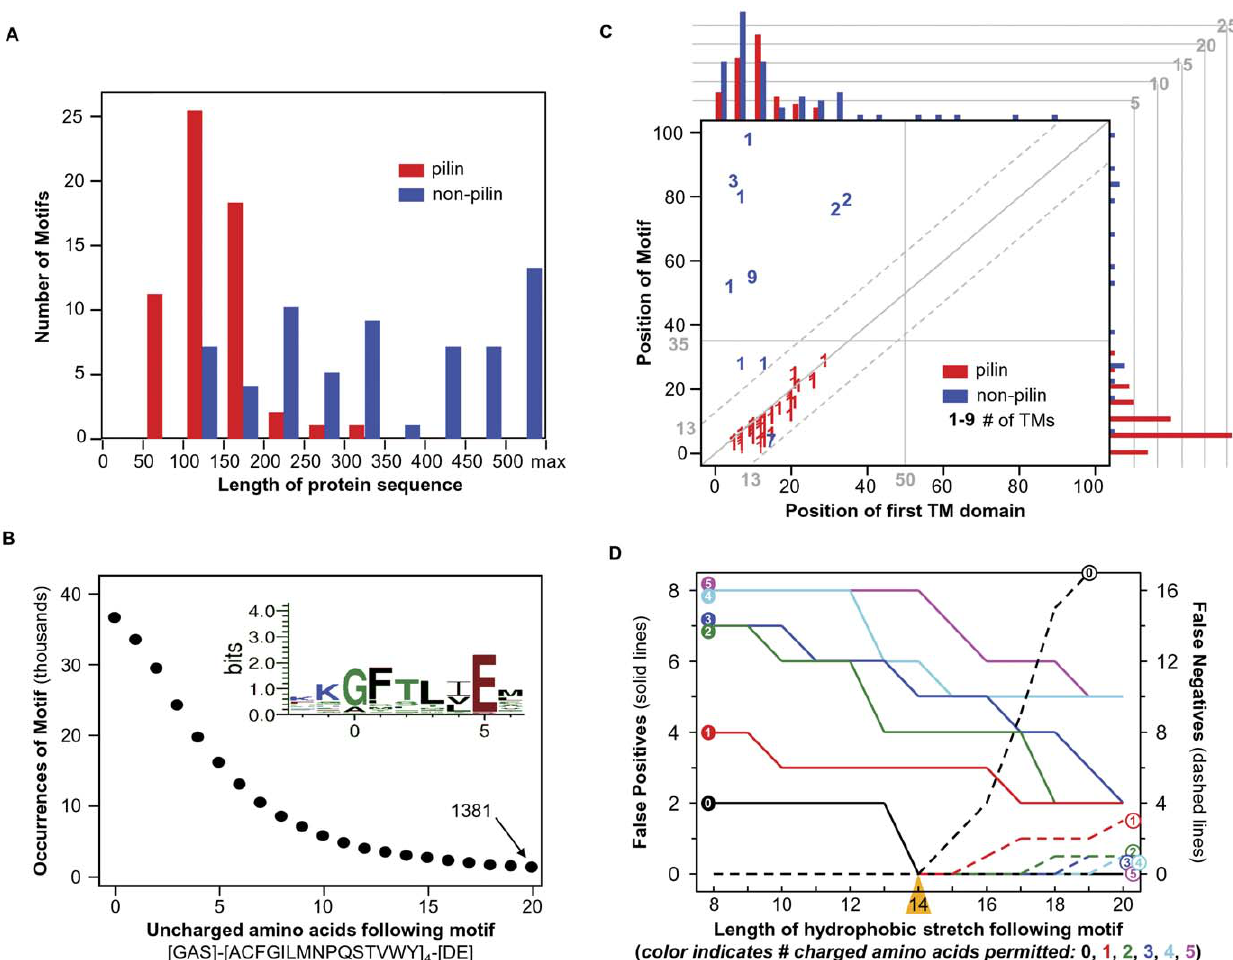
Figure 4. Analysis of type IV pilins features in Gram-positive bacteria training sets. ( A ) Type IV pilin sequences (red) are shorter than non- type IV pilins (blue). ( B ) Occurrence of the 6 amino acids core motif for type IV pilin peptidase cleavage, followed by a stretch of uncharged amino acids length 0–20 in 15 genomes (49,601 protein sequences; Table 2) used to define the positive training sets. , 75% of the these proteins include the six amino acid motif [GAS]-[ACFGILMNPQSTVWY] 4 -[DE] (inset), and 1381 contain this motif followed by 20 uncharged amino acids, suggesting that many are false positives. ( C ) Relative position of the type IV pilin motif and first transmembrane domain. Histograms depict the motif position (right) and transmembrane domain position (top) for type IV pilins (red) and non-type IV pilins (blue) in the training sets, only position within 100 amino acids are shown. Note that motif distribution is relatively even in non-type IV pilins, but occurs strictly within the first 35 amino acid residues in type IV pilins. Diagonal dashed lines indicate 6 13 amino acids distance between the type IV pilin motif and the first TM domain. In the scatter plot, number indicates the number of TM domains. ( D ) Assessing the effect of length and amino acid composition of the stretch subsequent to the type IV pilin cleavage pattern. Colored lines indicate the impact of permitting 0, 1, 2, 3, 4 or 5 charged amino acids within the hydrophobic stretch of length 8–20 amino acids. Solid lines represent false positives, and dashed lines false negatives. Seeking a hydrophobic stretch of 14 amino acids with no charged side chains (yellow triangle) yields optimal